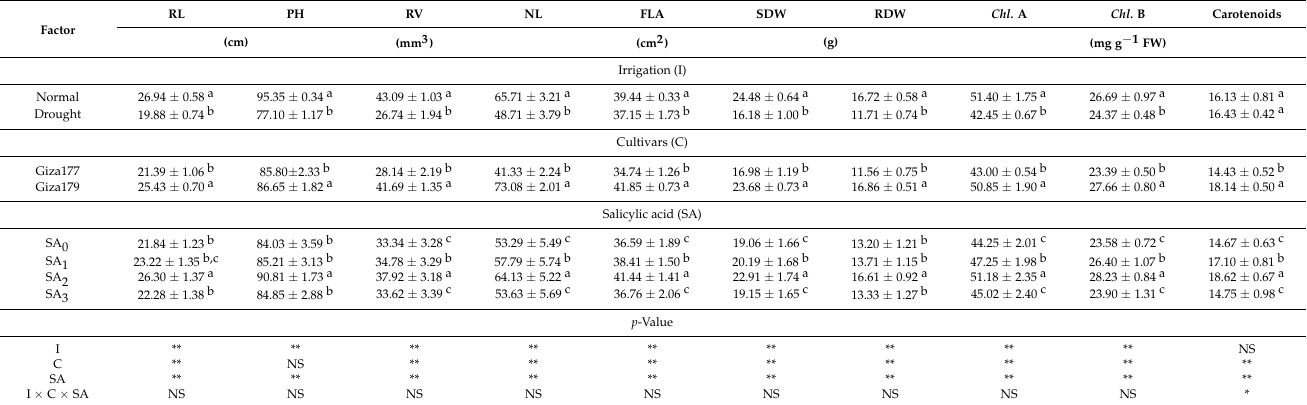
Table 5. Morpho-physiological traits of two rice cultivars (C) as affected by irrigation (I), salicylic acid (SA), and their interaction.